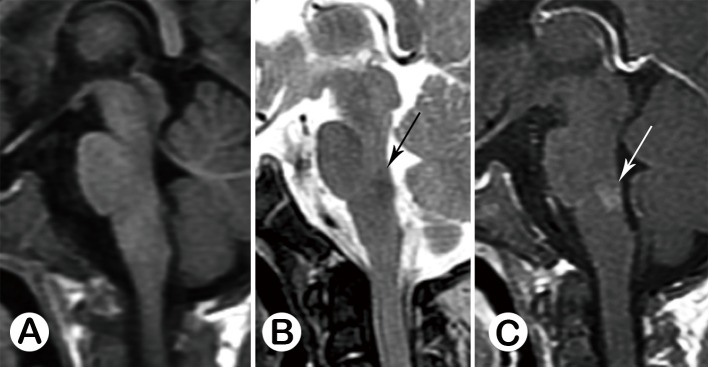
Acute stage type IV, Male, 6 months old, on the 6th day of the disease.There was no abnormal signal at the brainstem seen from sagittal T1WI (A). T2WI showed a hypo-intensive lesion at the posterior junction region of the pons and medulla (B, black arrow), which had moderate enhancement (C, white arrow).